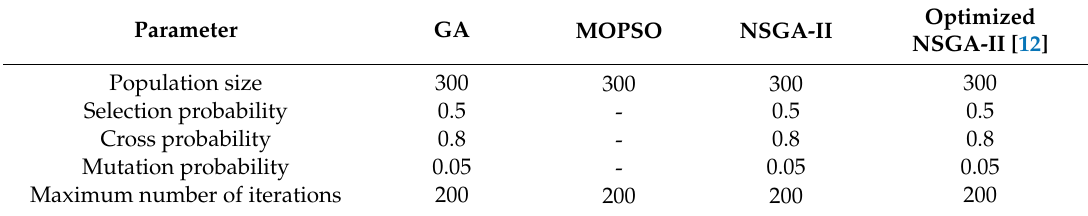
Table 2. Parameter setting of the genetic algorithm (GA) and the improved